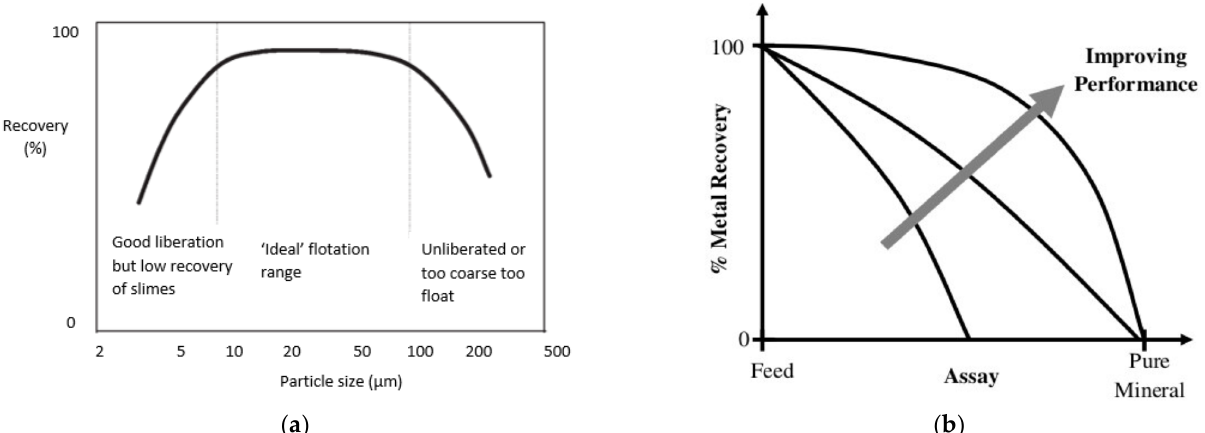
Figure 4. ( a ) Typical recovery–particle size curve, adapted from Pearse [47]; ( b ) typical recovery- grade curve, adapted from Klassen and Mokrousov [48]. curve, adapted from Klassen and Mokrousov